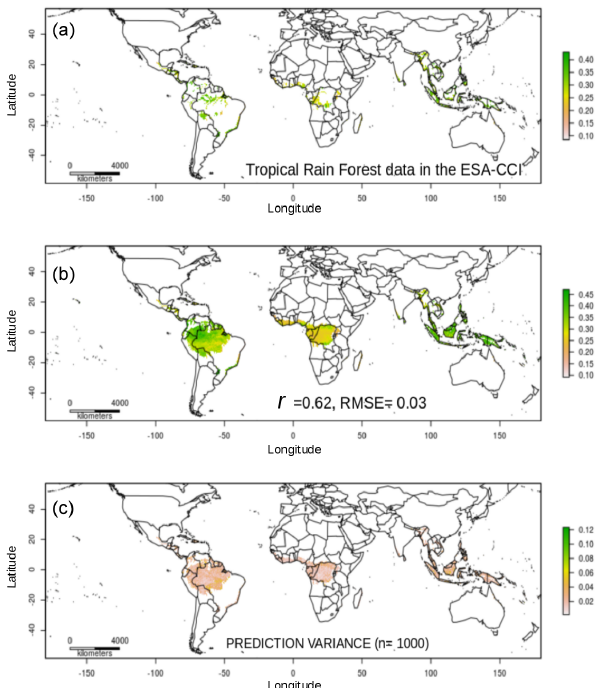
Figure A3. Soil moisture across tropical rain forests of the world based on the data available in the ESA-CCI soil moisture product (4.5) for the year 2018 (a) . We show the soil moisture prediction (b) and the soil moisture prediction variance using only the data avail- able for tropical rain forests (c) . Note that the correlation between observed and predicted decreased to 0.62, most likely due to the limited information for modeling these ecosystems; however the root mean squared error is comparable with a model using all global data (e.g., < 0.04).